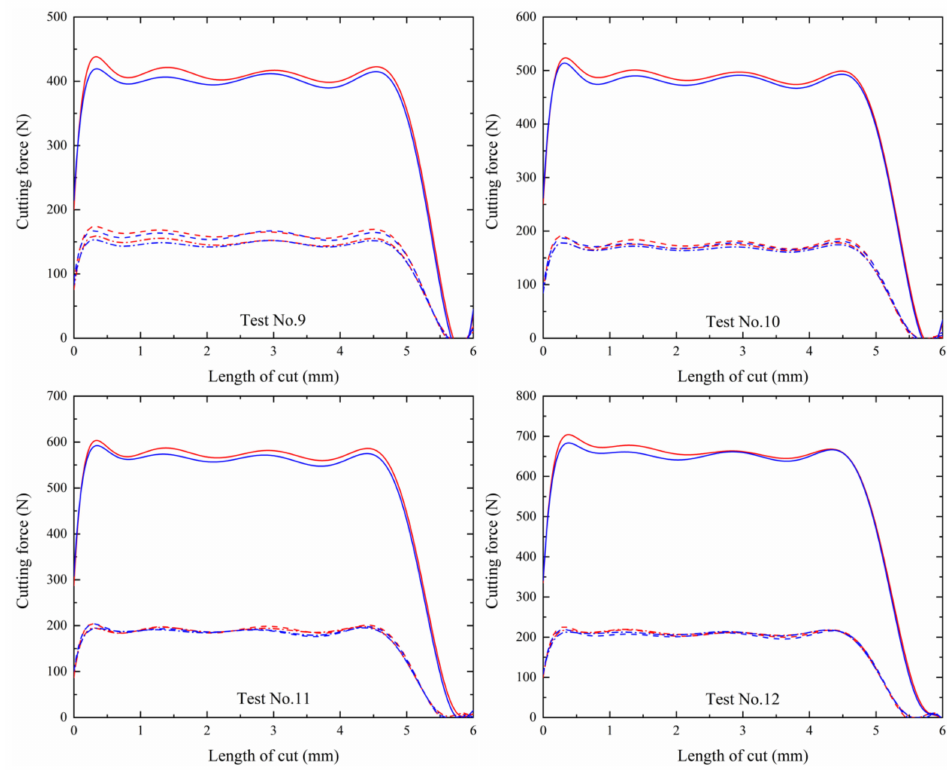
Figure A1. Ten-order polynomial fitting diagram of cutting forces in 24 simulations.